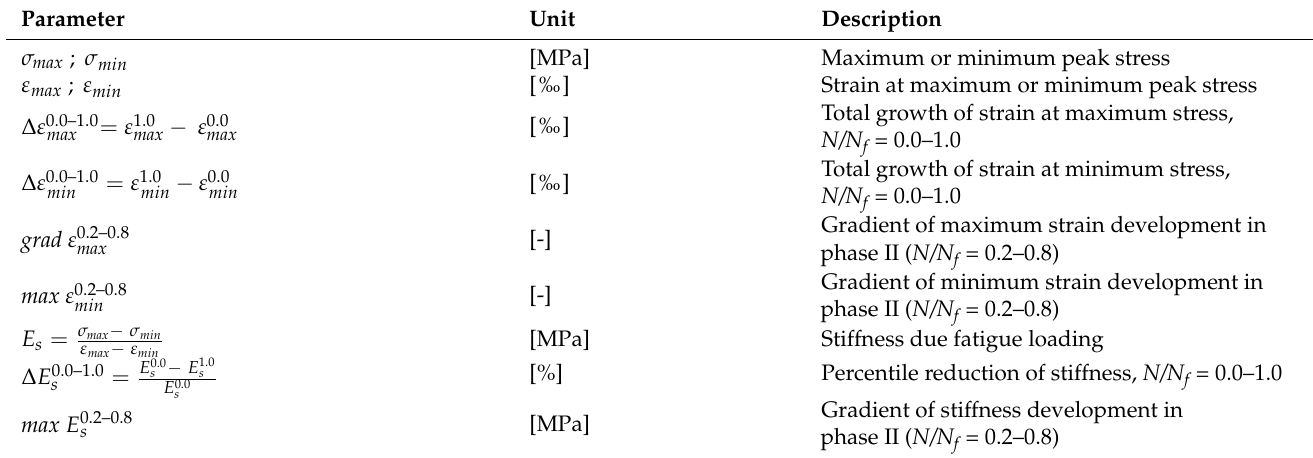
Table 4. Overview of parameters